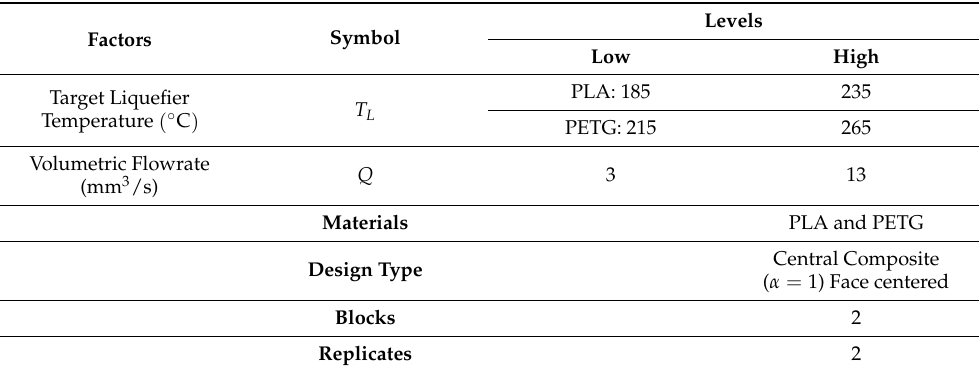
Table 1. Experimental design setup for output melt temperature prediction. Factors Symbol Target Liquefier Temperature ( ◦ C )